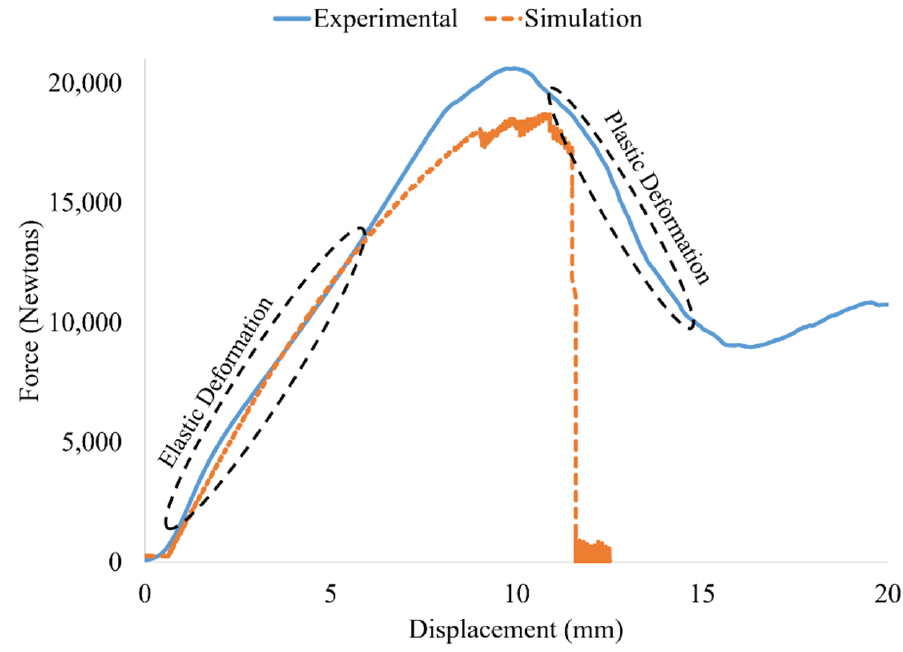
Figure 18. Comparison of Force vs. Displacement curve for average experimental data of three specimens and numerical simulation.